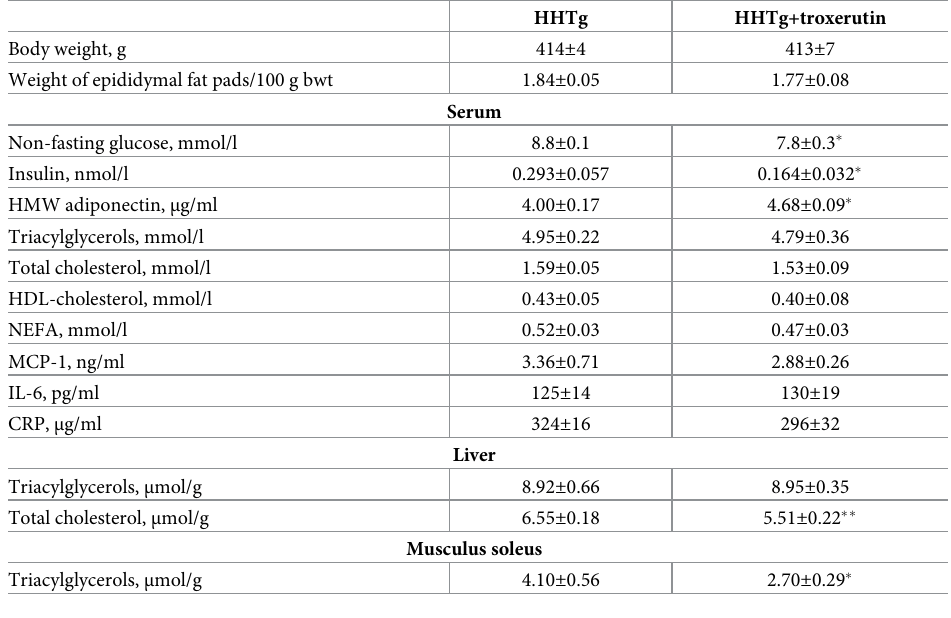
Values are mean ± SEM for each group, n = 8 for both group � p < 0.05 �� p <